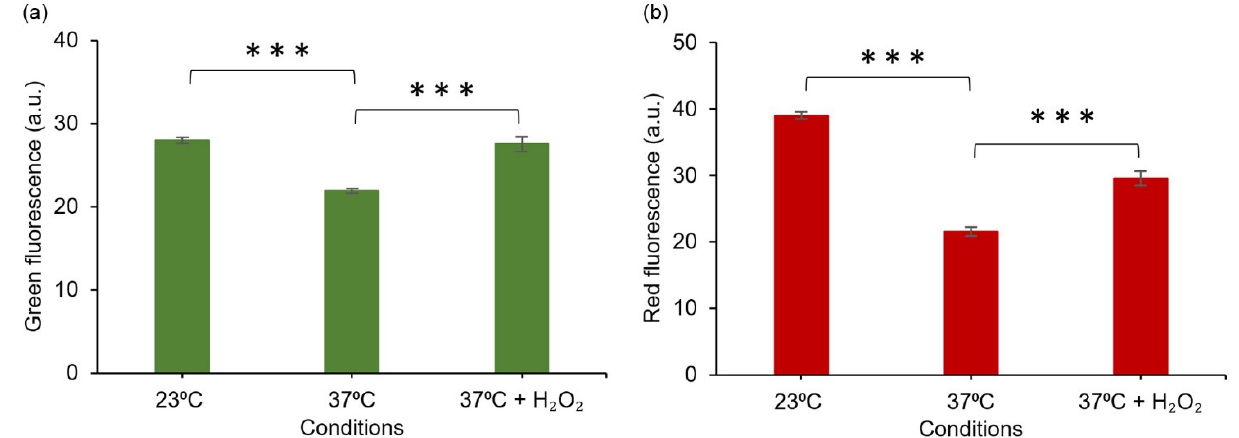
Figure 7. Fluorescent response of E. coli DH5α /pJ4040-IscR-C towards intracellular oxidative stress induced by reduced temperature (23 °C) and H 2 O 2 supplementation, based on quantitative analysis of confocal microscopy images. ( a ) Green fluorescence signal representing the commercial CellROX probe and ( b ) red fluorescence representing the designed E2-Crimson reporter system, as determined from corresponding segmented E. coli objects. The averages and standard deviations have been calculated based on three independent datasets. The differences between the samples are statistically significant, p ≤ 0.001 (***).